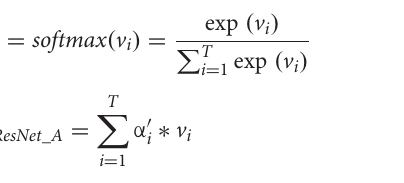
TABLE 3 | Counting rules for the numbers of the variables. Normal AF Other Noisy Total Normal